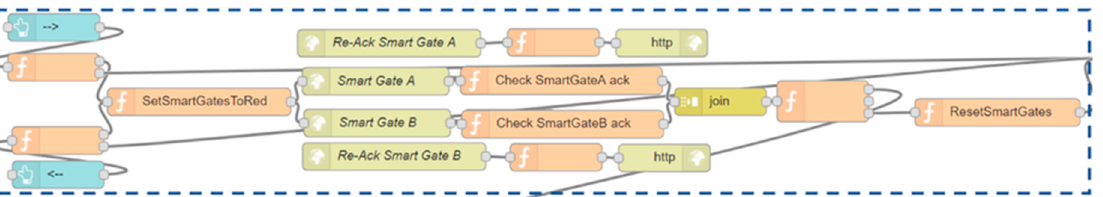
Figure 9. First sub-flow that allows the city operator to set on both smart gate a “Prohibited Access” message. The entire flow is shown in Figure 8.